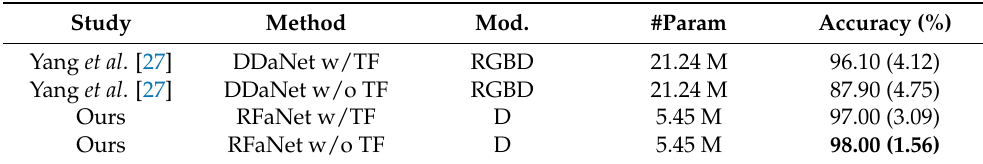
Table 5. Results on the transfer learning where the NTU dataset is the target dataset. Numbers in parentheses indicate the standard deviation of the LOOCV across 10 subjects. Mod.: modality; #Param: number of parameters of the model; w/TF: with transfer learning; w/o TF: without transfer learning. Bold values indicate the highest classification accuracy among the four